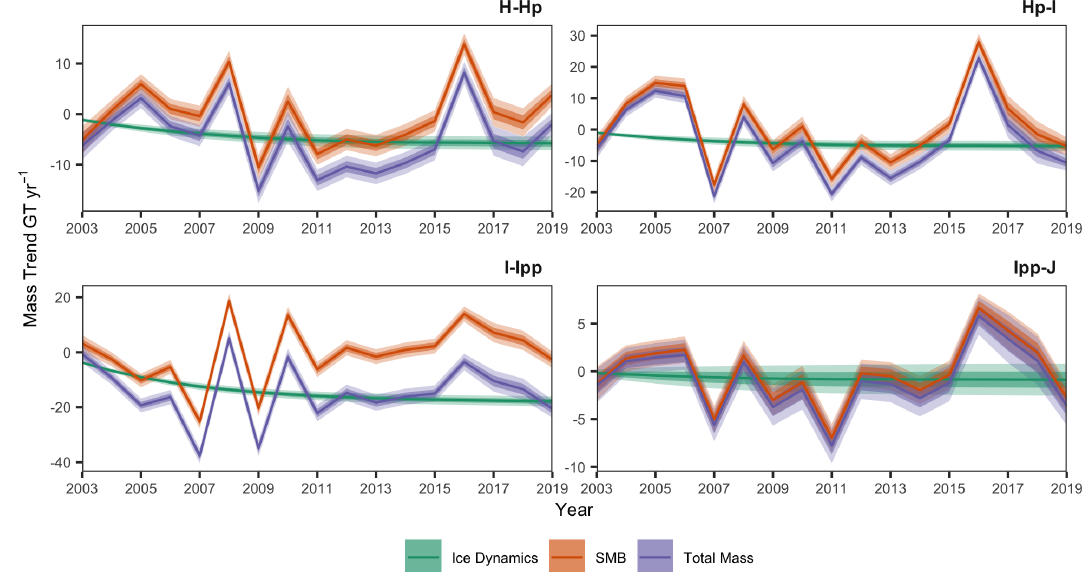
Figure 4. BHM mass trends and constituent processes for each individual drainage basin in the study region (Rignot et al., 2011b, 2013); see Fig. 1 for drainage basin locations. Dark and light ribbons represent the 1 σ and 2 σ uncertainty of mass trends, respectively.